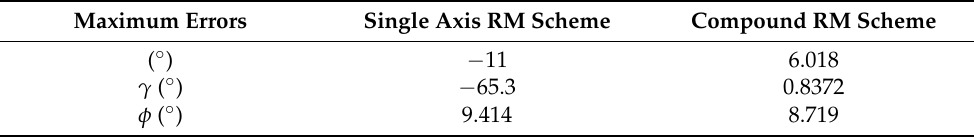
Figure 26. The navigation information of the b-frame obtained after coordinate system transformation: ( a ) angular velocity information; ( b ) specific force information. Table 11. Maximum errors between two rotational modulation schemes